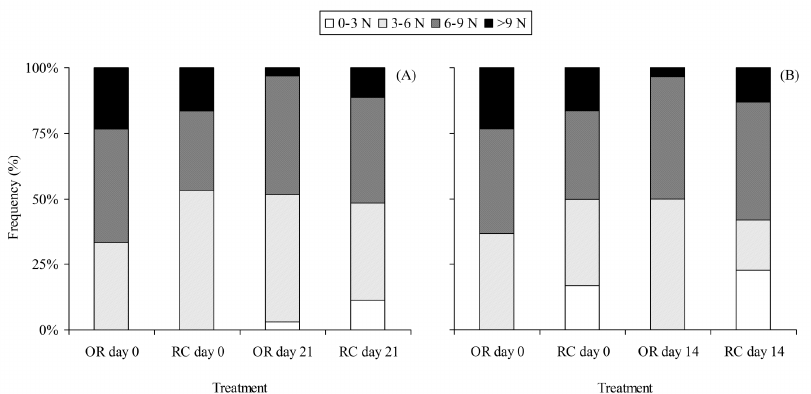
Fig. 3: Effects of rain cover on frequency of classes of resistance to stem removal (RSR) in ‘Adriana’ and ‘Noire de Meched’ cherries after harvest and stor - age. (A), ‘Adriana’; (B), ‘Noire de Meched’. Each column represents 30 cherries. OR, Orchard Uncovered; RC, Rain Covered Orchard. RSR classes: 0-3 N, 3-6 N, 6-9 N, > 9 N. Data were analyzed by c 2 tests. When data were divided into two classes, 0-6 N and > 6 N, (due to small numbers in some classes), P > 0.05 in both A and B. When data were divided into three classes (0-6 N, 6-9 N, > 9 N), all dual comparisons in both A and B were not significant ( P > 0.05).